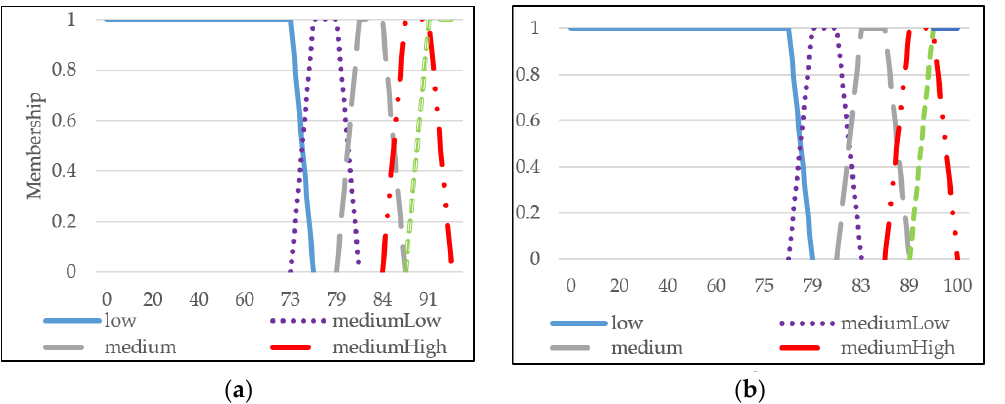
Figure 8. MF for RU. ( a ) Initial MF. ( b ) MF after configuration.